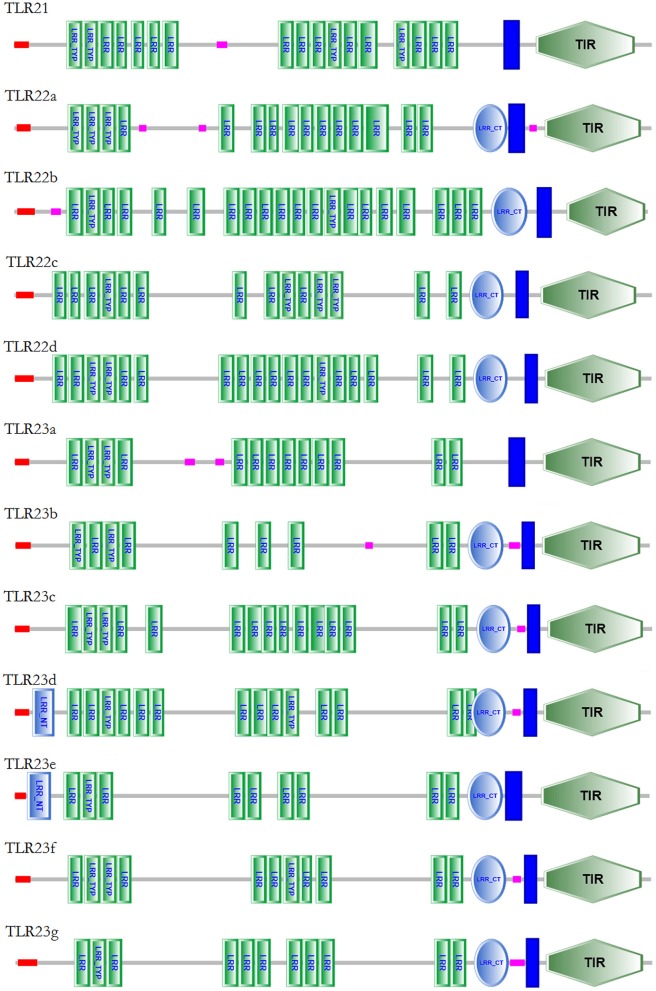
Protein domain structures of Tlr21, Tlr22, and Tlr23 proteins in B. pectinirostris. The domain organizations of Tlr21, Tlr22, and Tlr23 in B. pectinirostris were predicted using SMART, SignalP, and TMHMM analyses. LRR, leucine-rich repeat; LRR-TYP, leucine-rich repeat typical subfamily; TIR, Toll/IL-1 receptor; NT, N-(nitrogen) terminal; CT, C-(carboxyl) terminal; , signal peptide; , transmembrane region; , low complexity region.